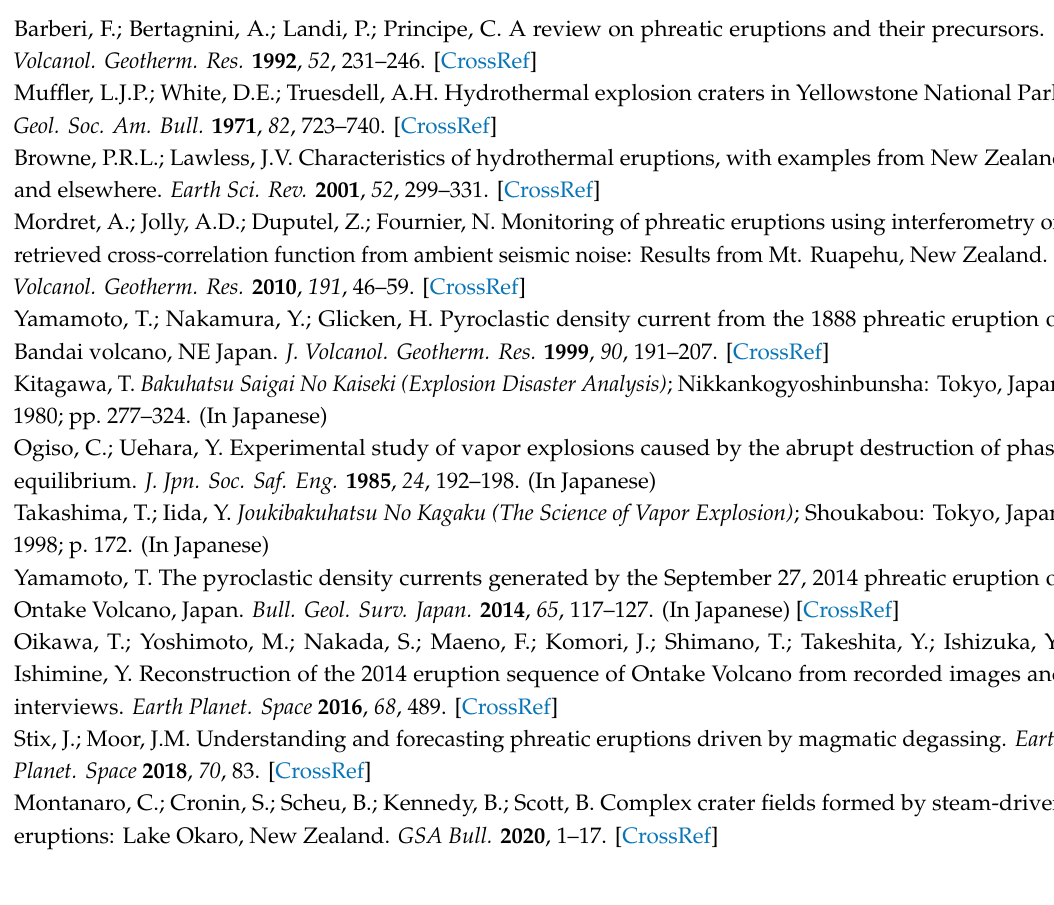
Figure S1: The distribution of geothermal anomaly area over 50 ◦ C in Ioyama fumarole area; Figure S2: Digital elevation models and photographs; Figure S3: Photomicrographs of ashy deposit grains; Figure S4: XRD analyses; Table S1: The oxygen and hydrogen isotope analyses of hydrothermal water from the